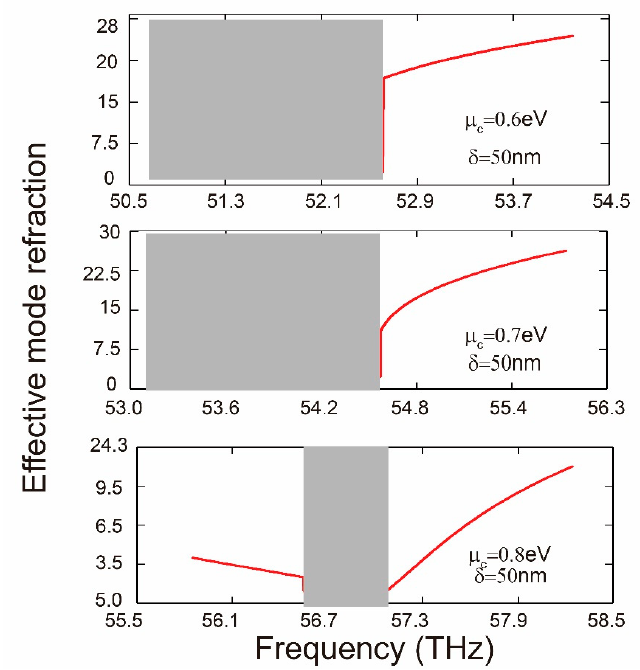
Figure 4. Effective mode refraction for the MGPW as a function of frequency with different chemical Figure 4. E ff ective mode refraction for the MGPW as a function of frequency with di ff erent chemical potentials in the core. potentials in the core.